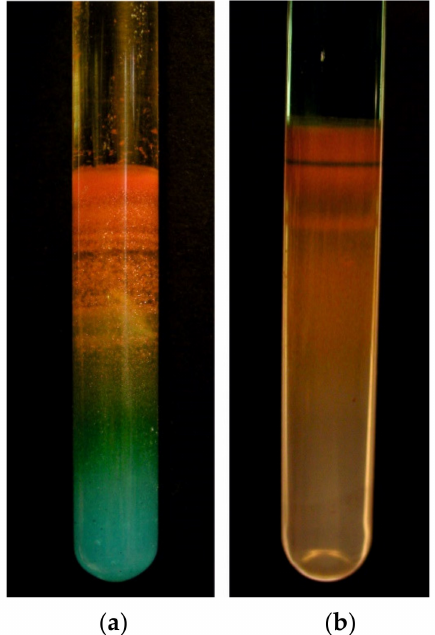
Figure 10. Influence of reagent position on the character of the product: ( a ) Macroscopic crystals